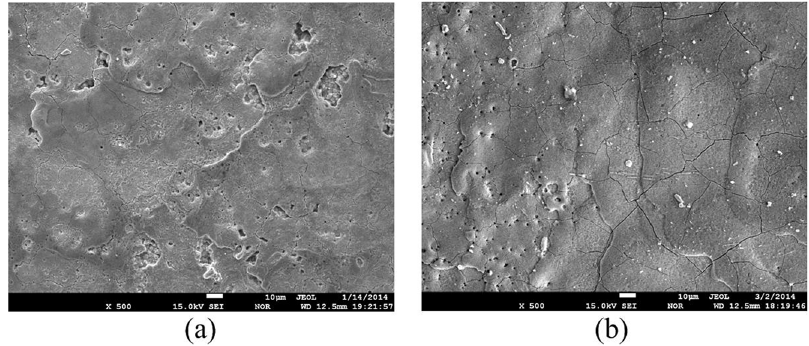
Figure 16. Microcracks on machined ZnO/Al 2 O 3 surfaces with different electrical resistivities: (a) 15 V ? cm; (b) 6.3 V ? cm.